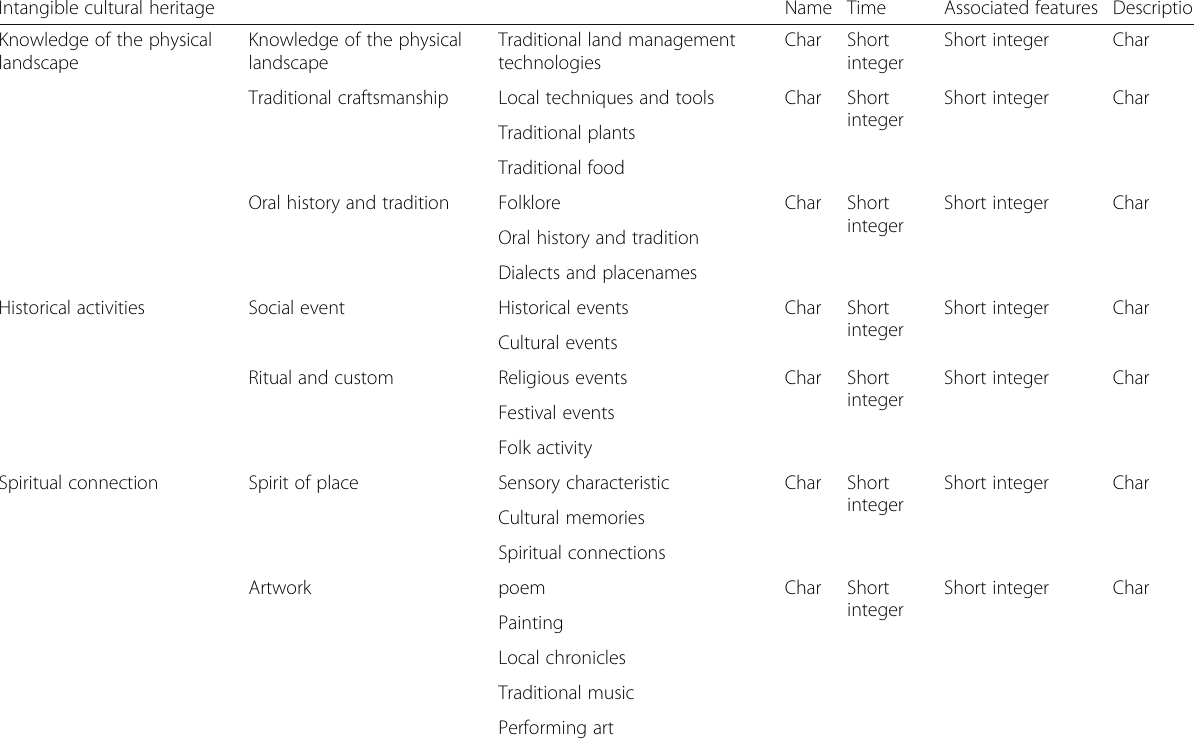
Table 2 Feature Attribute in Slender West Lake geo-database: Intangible cultural